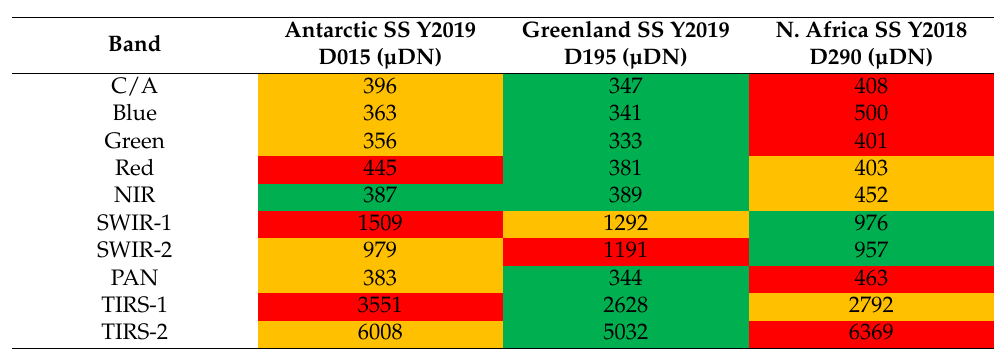
Table 5. Summary of scene average Streaking Metrics for three separate SS locations; red data is statistically the worst, followed by yellow data, and green data is statistically the best; if multiple cells are the same color that data is statistically equal, as proven by the t -test.